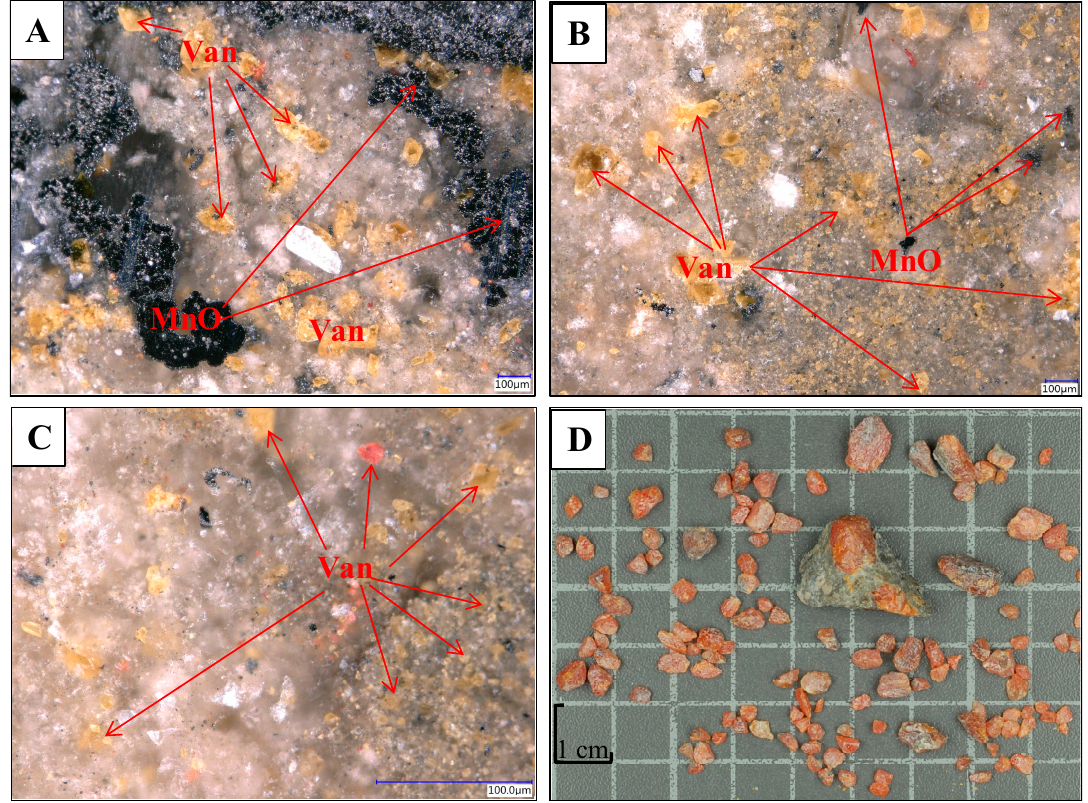
Figure 4. Optical microscope images of cemented materials ( A – C ): Van—Vanadinite, MnO—Manganese oxide; ( D ) Hand-specimen photograph of coarse vanadinite particles (“red” vanadinite).